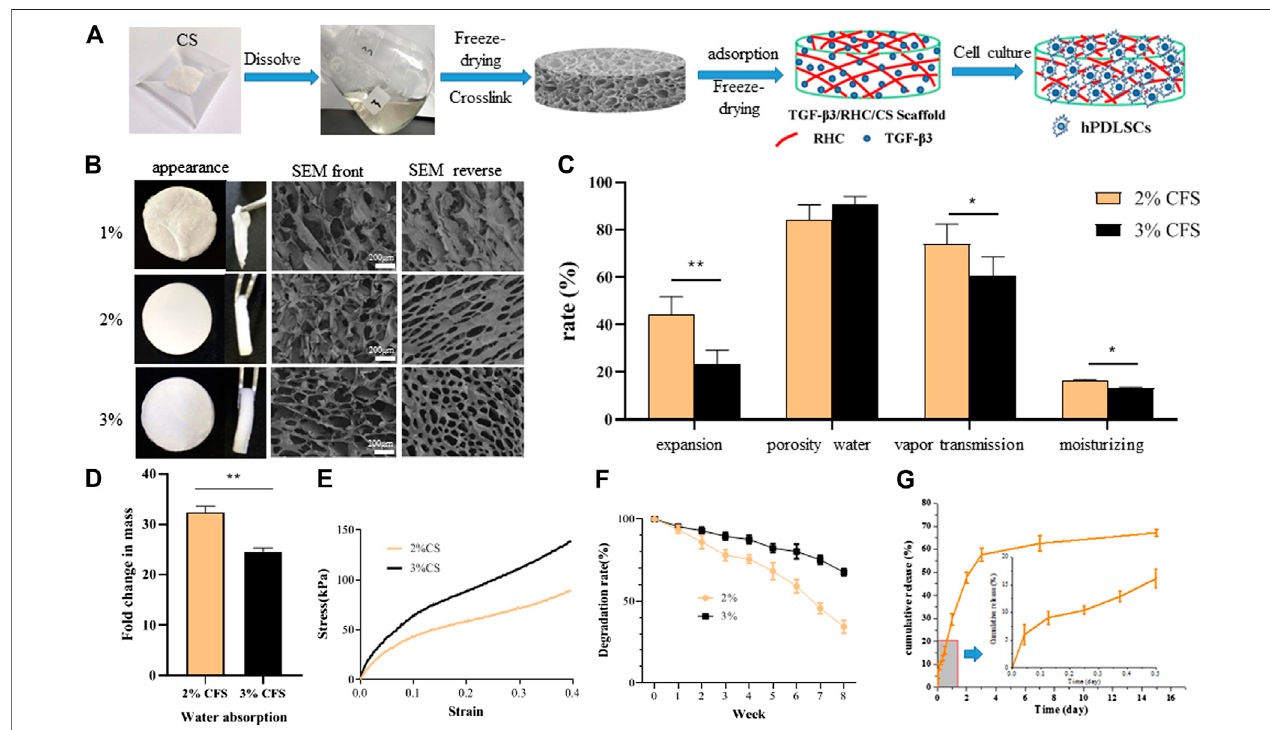
FIGURE 1 | Preparation and physicochemical properties of CFS (A) CFS preparation process (B) . SEM observation of freeze-dried sponge morphology (C) Expansion rate test; Porosity of freeze-dried sponge, Water vapor transmittance test and Moisture retention test (D) Water absorption capacity test ( n (cid:1) 5, * p < 0.05, ** p < 0.01 vs 2% CS) (E) Mechanical properties (F) Degradation experiment (G) release curve of TGF- β 3 from 2% freeze-dried